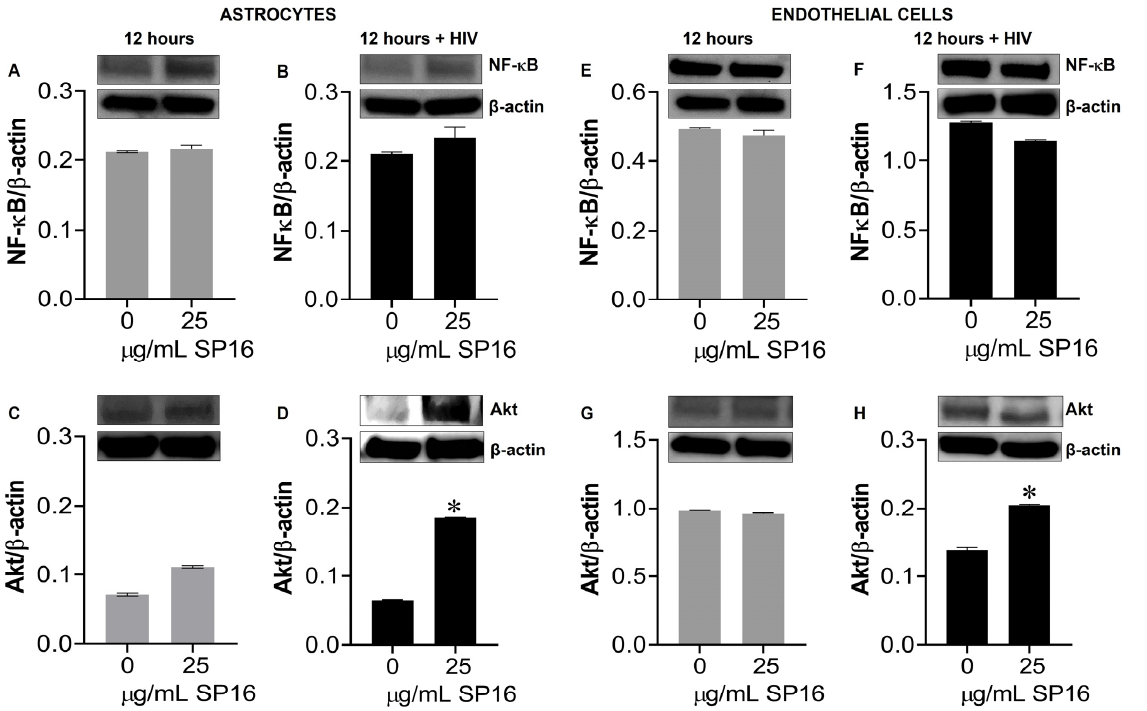
Figure 6. SP16 increases the expression levels of Akt in astrocytes and endothelial cells. Cell lysates were collected after 12 h and used to measure NF- κ B ( A , B , E , F ) and total Akt ( C , D , G , H ) expression levels by immunoblotting. Gray bars = non-infected cells, black bars = infected cells. Results are reported as the mean ± SEM of three independent experiments. Data was analyzed using one or two-way ANOVA analysis followed by Dunnett multiple comparisons. A value of p < 0.05 was considered significant. * vs.